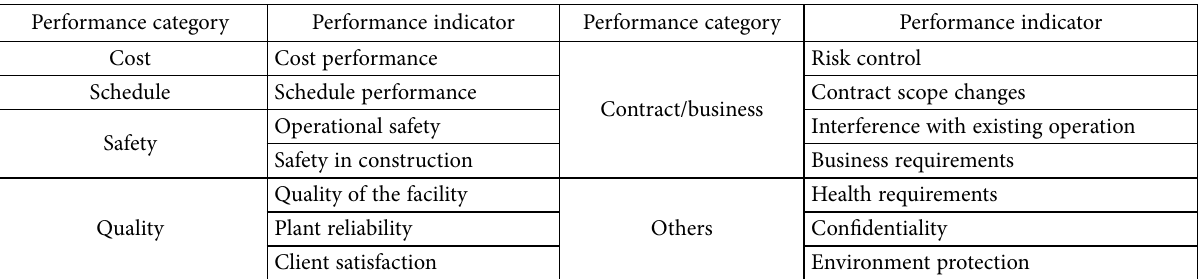
Table 2. Framework of project performance indicators